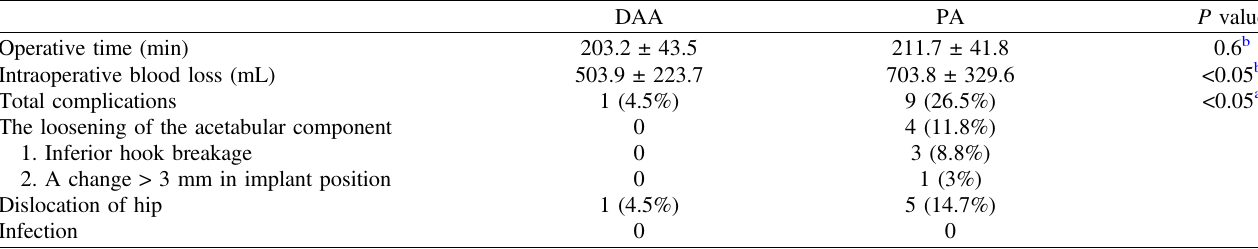
Table 2. Surgical data and